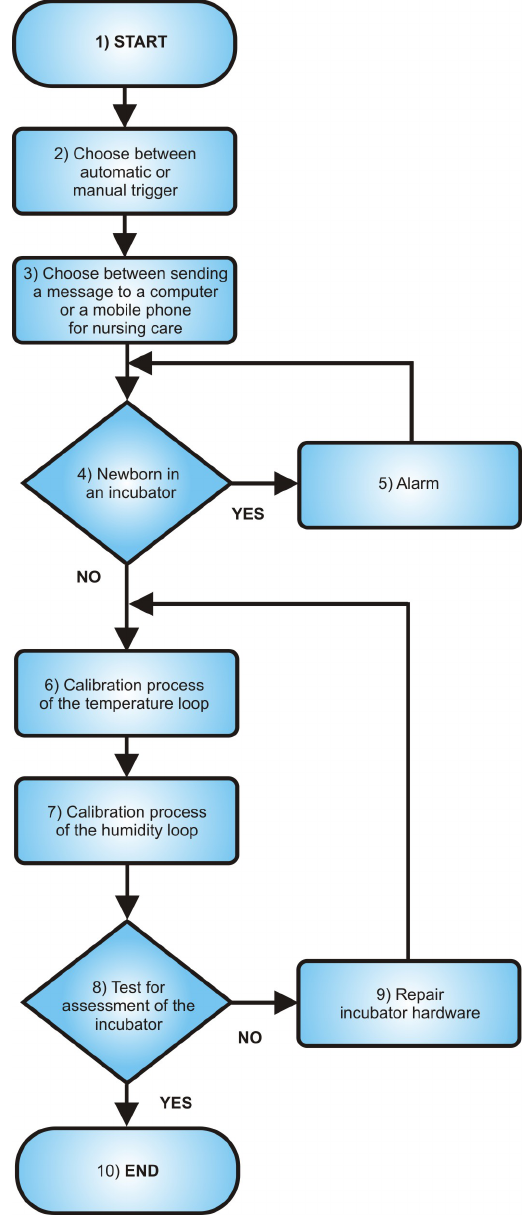
Figure 12. Flowchart representing the calibration process.